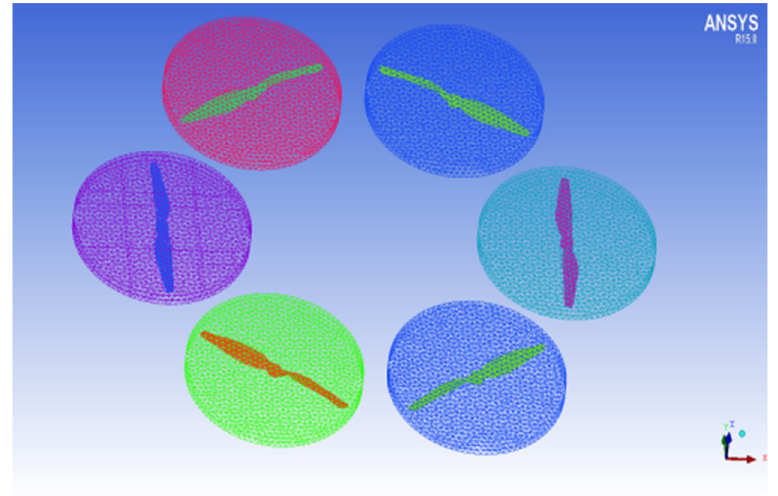
Figure 6. Grid division of the six rotor and the dynamic domain. The external regions containing six rotors were divided, with about 1.6 million grids, as shown in Figure 7.